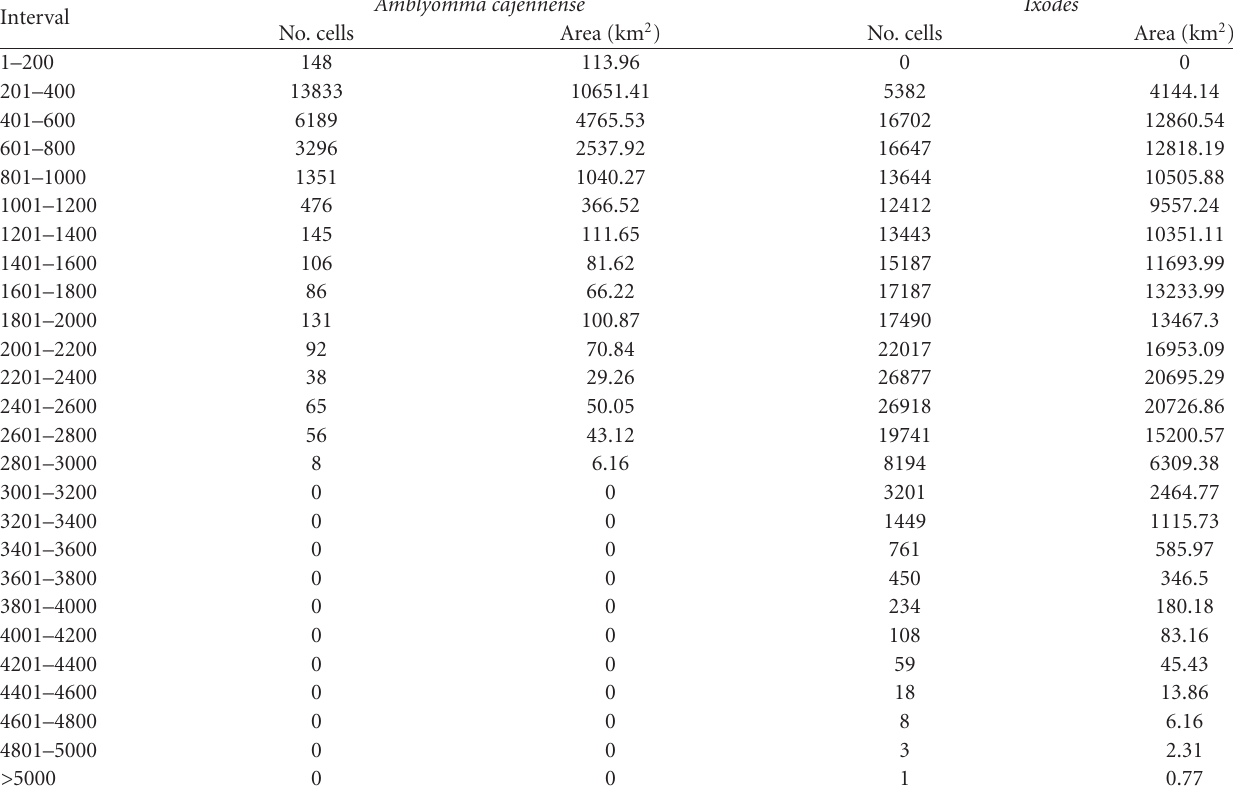
Table 4: Altitudinal intervals and predicted ranges of Amblyomma cajennense and the Ixodes group.